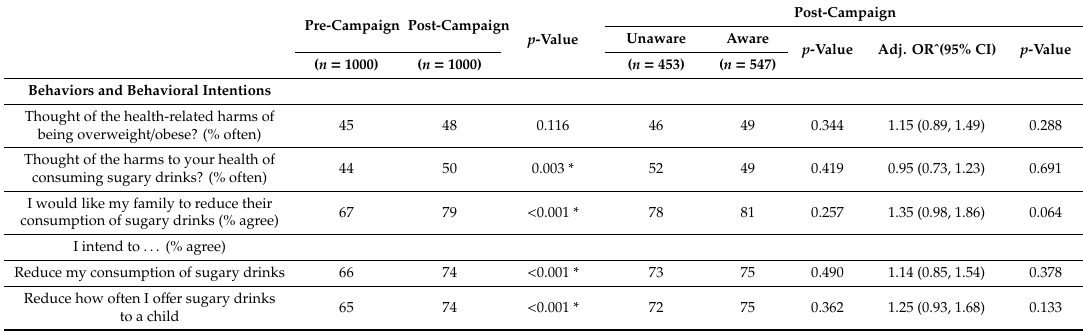
Table 6. Behaviors and behavioral intentions among respondents in the pre-campaign and post-campaign periods, including a comparison of post-campaign respondents who were aware and unaware of the